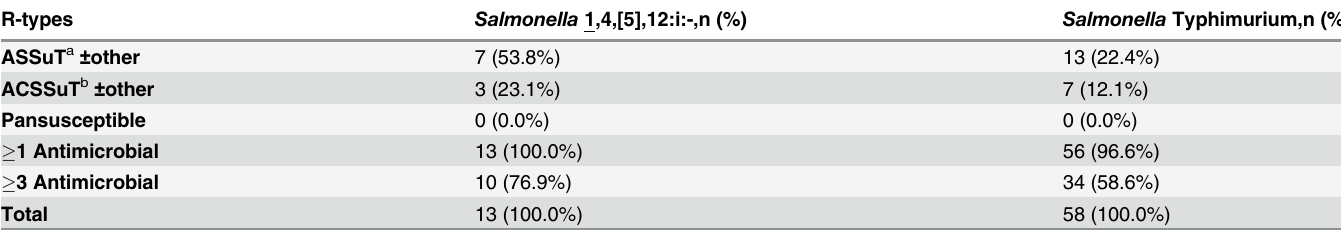
Table 1. Antimicrobial resistance patterns of Salmonella 1,4,[5],12:i:- and Salmonella Typhimurium